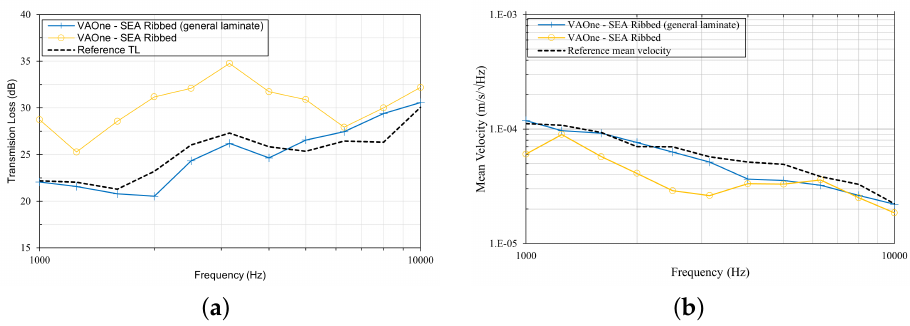
Figure 25. Vibro-acoustic responses of the equivalent SEA Ribbed model (TL and velocity optimisa- tion): ( a ) sound transmission loss and ( b ) space-average mean vibration